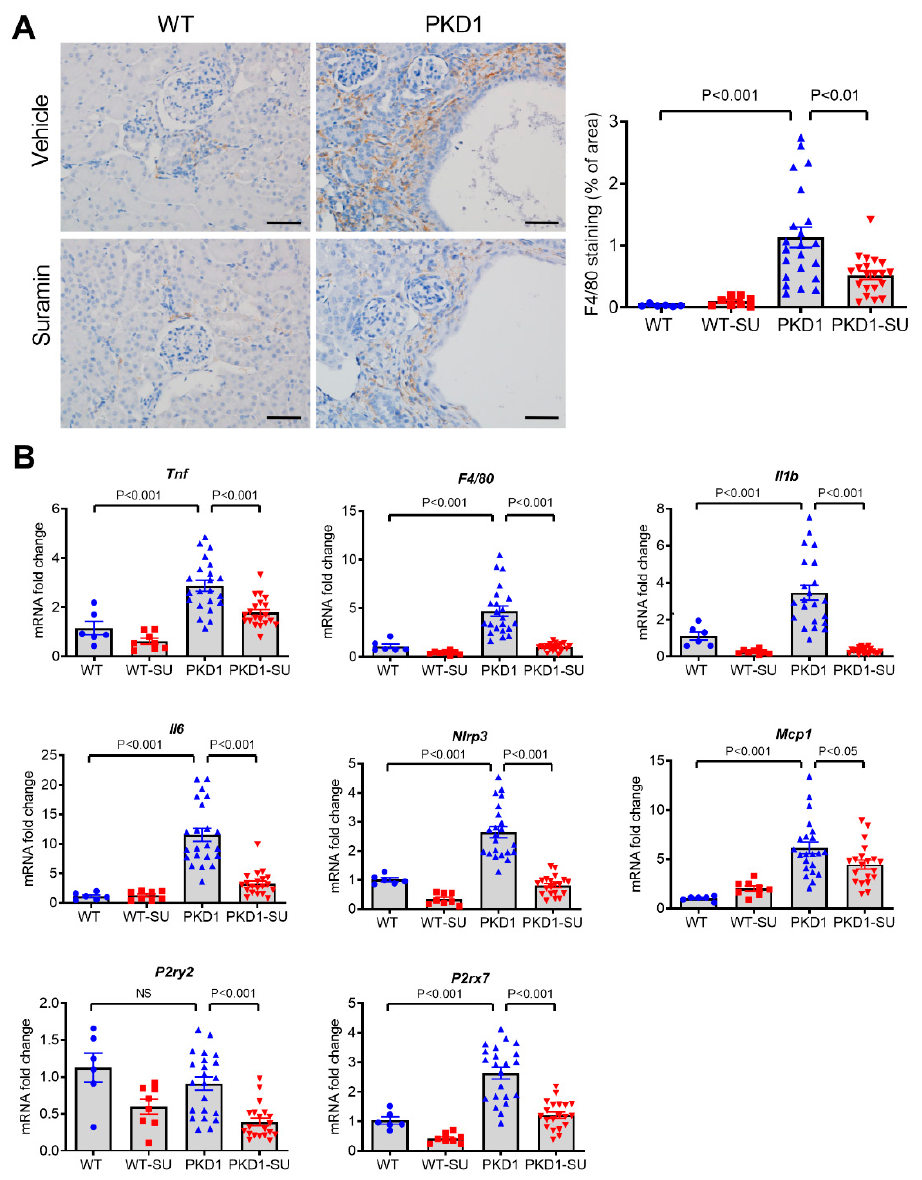
Figure 4. Suramin treatment inhibited renal inflammation and macrophage infiltration. ( A ) Im- munostaining of kidney sections for F4/80 in different treatment groups as indicated. Quantitative image analysis showed a significant decrease in the percentage of F4/80 positive cells in the suramin- treated Pkd1 -miR Tg mice compared with the vehicle-treated controls. Scale bar, 50 µ m. ( B ) Suramin treatment reduced the mRNA expression of pro-inflammatory genes and purinergic receptor genes in the kidneys, as determined by qRT-PCR (n = 6, 8, 22, and 20 per group, respectively). Data are mean ± SEM.